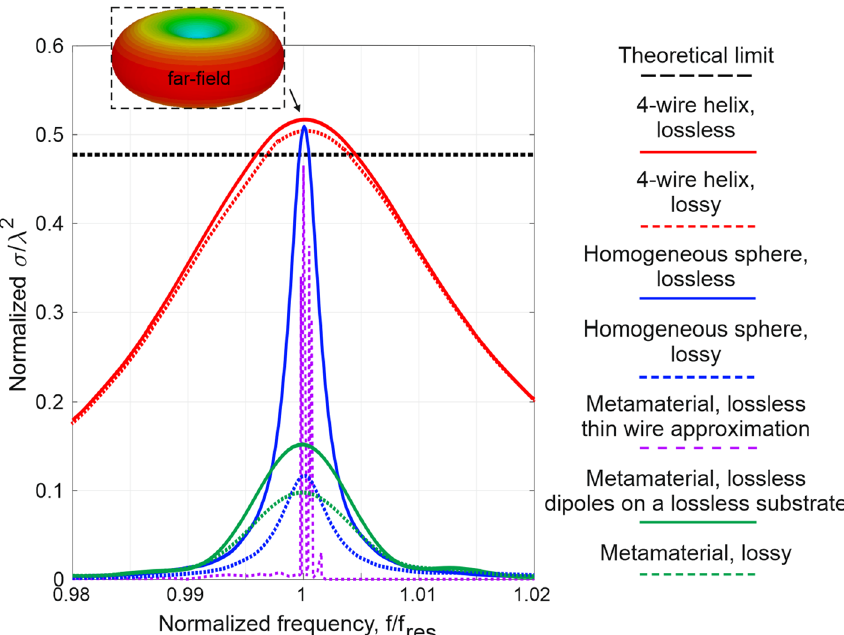
Figure 5. Comparison between the scattering performances of different objects indicated in the legend and Table 2. The frequency axis is normalized to a resonant frequency and the peak to a resonant wavelength squared per each scatterer individually. The dashed black line is the theoretical single-channel limit. The upper inset is the far-field scattering diagram of an electric dipole (the identical shape to each structure